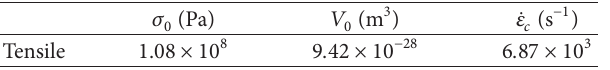
Table 2: Material constants of the new model.